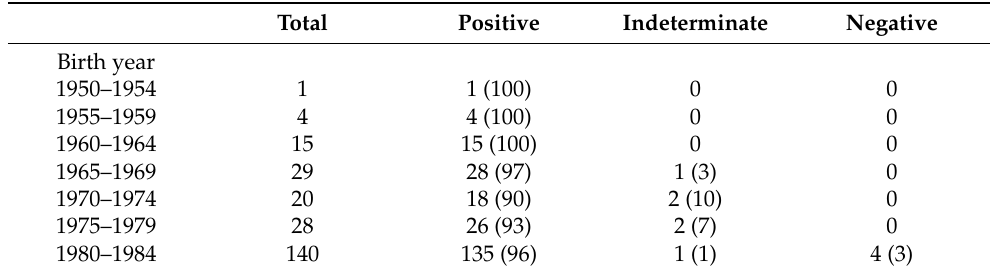
Table 1. Immunologic status of the varicella-zoster virus of healthcare workers according to birth year and age